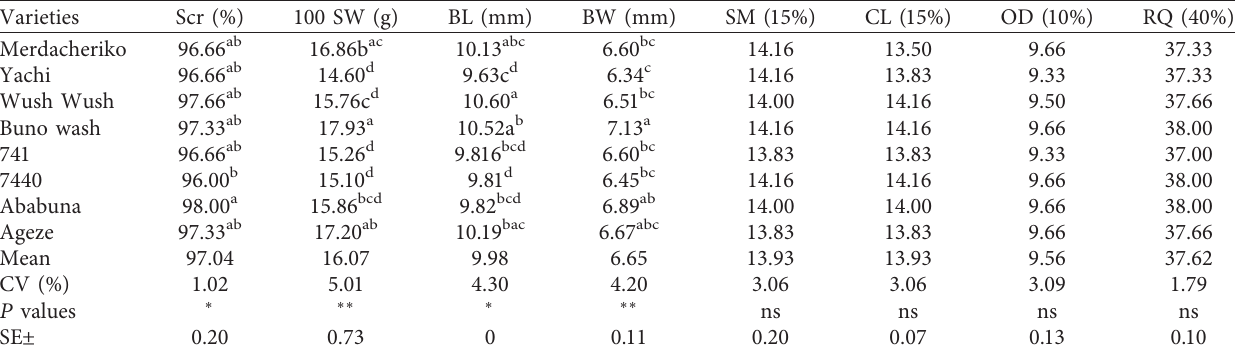
Table 3: Physical quality parameters of beans of Arabica coffee varieties grown in AARC during the 2018 main cropping season. Coffee varieties